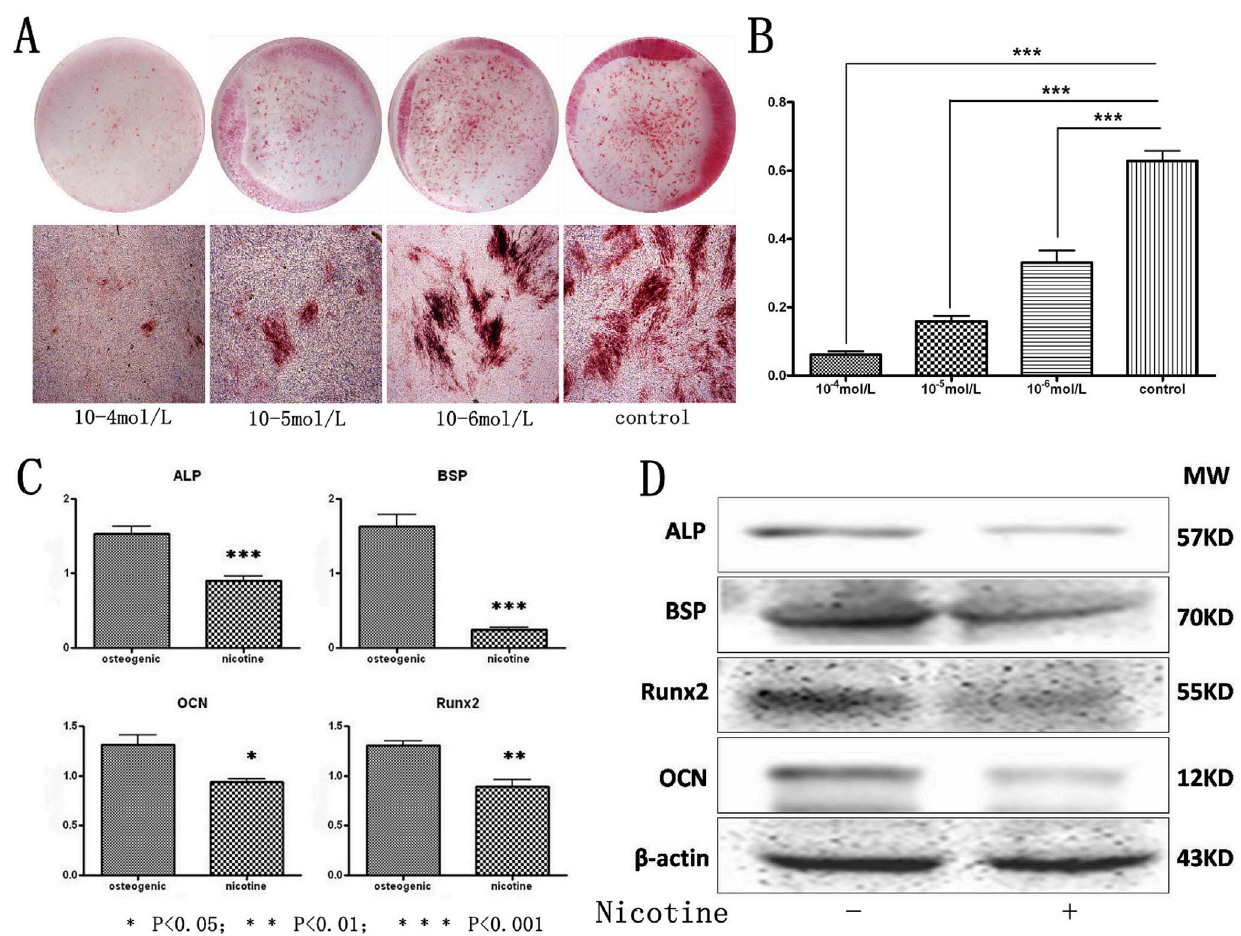
Figure 3. Nicotine deteriorates the osteogenic differentiation capacity of hPDLSCs. A : hPDLSCs treated by 10 2 4 –10 2 6 mol/L nicotine were cultured in osteogenic medium and osteogenic differentiation was determined by Alizarin red S staining after 21 days. Representative entire plate views of alizarin red staining in 6-well plates for PDLSCs from each group. B : The quantity result for Alizarin Red S staining; C : The expression of osteogenic related genes Runx2, BSP, ALP and OCN were determined by qRT-PCR after 14 days of culturing with osteogenic supplement. D : The expression of osteogenic related protein Runx2, BSP, ALP and OCN were determined by western blot after 14 days of culturing with osteogenic supplement. Data represent the means 6 SD. *p , 0.05 (n=3).